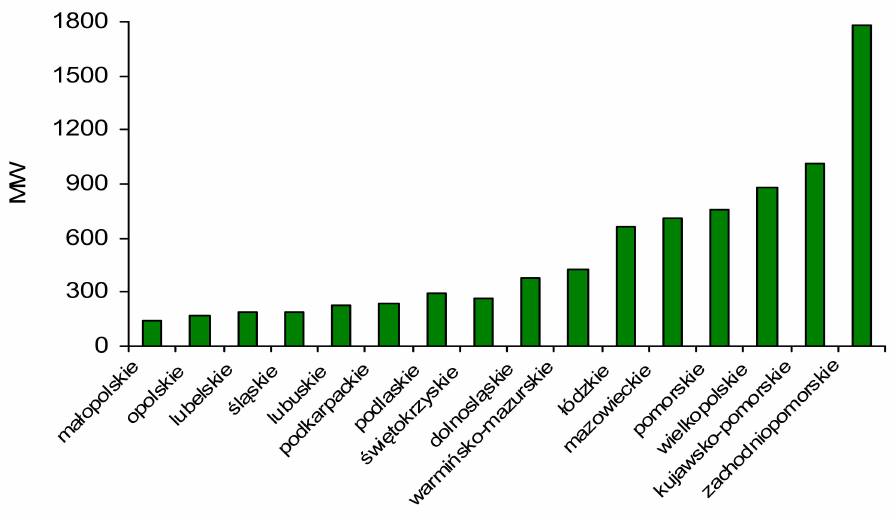
Figure 1. RE installations capacity in respective voivodships of Poland. Own elaboration based on data from